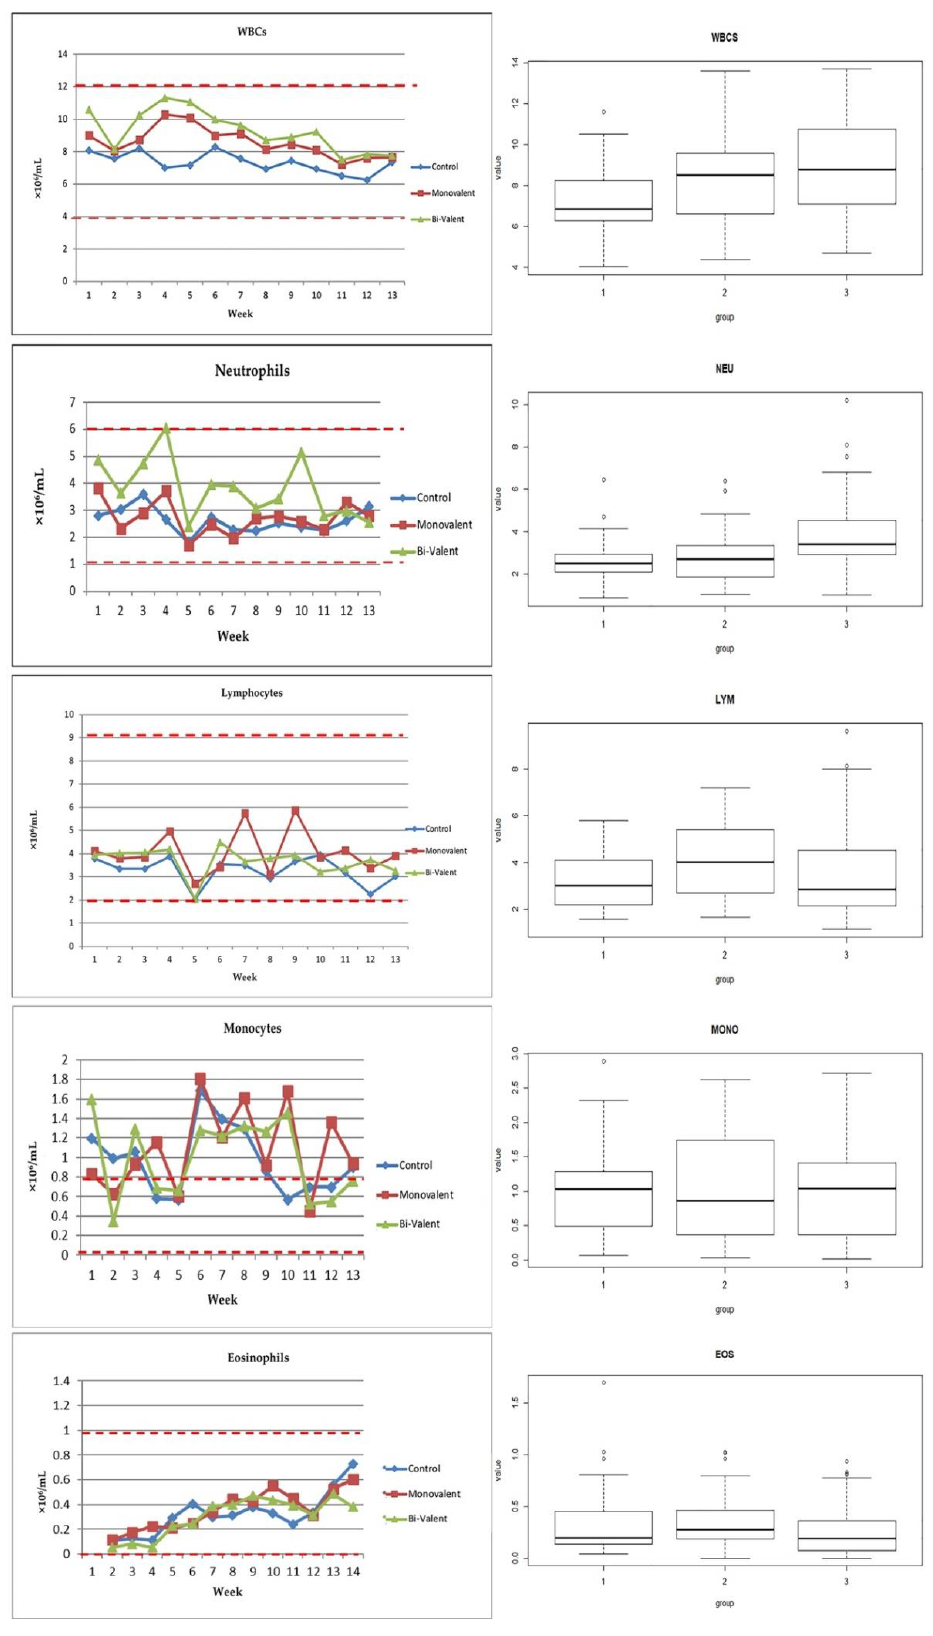
Figure 2. Total and differential leukocyte count (graphs and boxplots). WBCs: total leukocytic count; NEU: neutrophils; LYM: lymphocytes; MONO: monocytes; EOS: eosinophils; group 1 (control), group 2 (monovalent vaccine), group 3 (bi-valent vaccine); the red dotted line refers to the physiological threshold of the parameter value in ovine